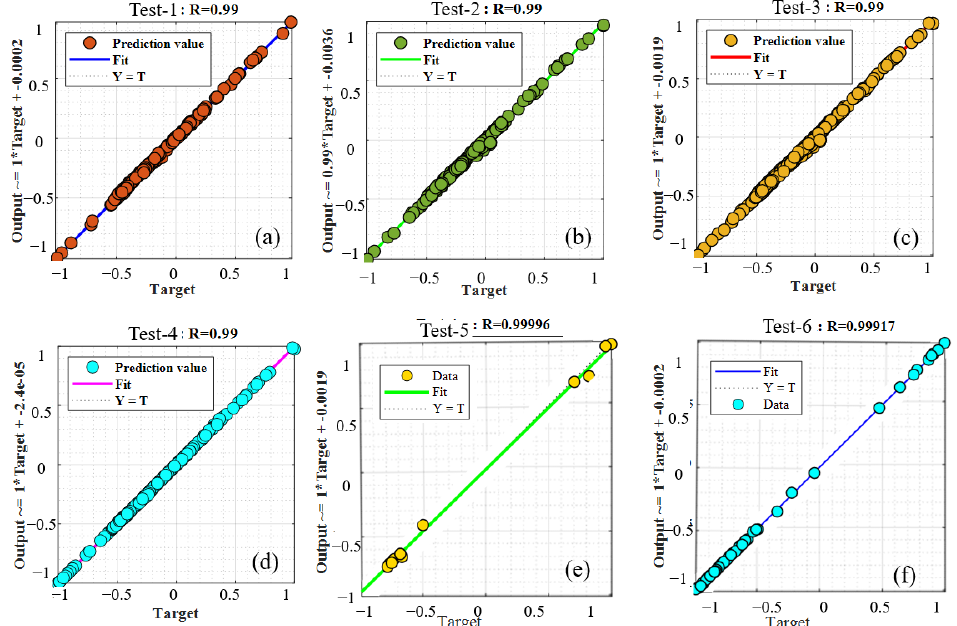
Figure 27. Prediction performance for selected testing data points: ( a ) Test-1; ( b ) Test-2; ( c ) Test-3; ( d ) Test-4; ( e ) Test-5; and ( f ) Test-6.